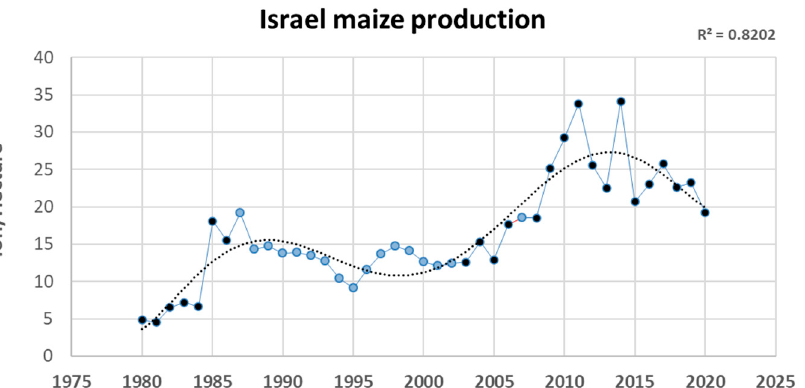
Figure 1. Israel maize production per metric hectare between the years 1980 and 2020. Data from FAOSTAT, 2020 Food and Agriculture Commodity Production. Values in dark blue are official data. Values in light blue are unofficial data or estimations. The trend line is a sixth-order polynomial.